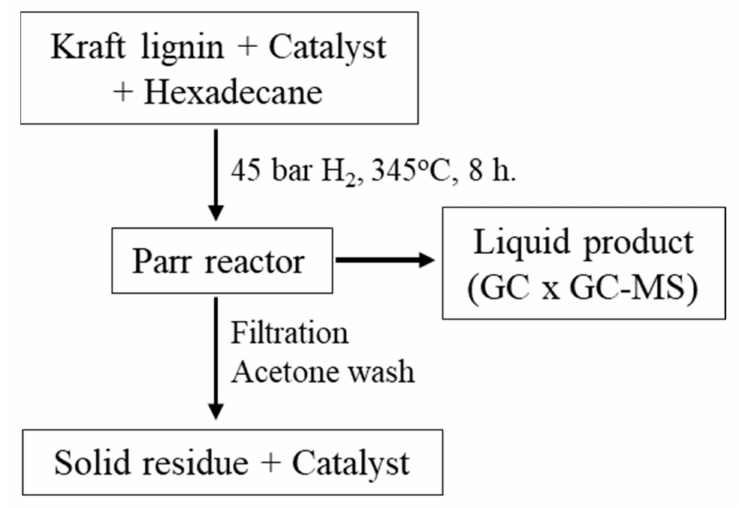
Scheme 1. Lignin hydrotreatment and workup